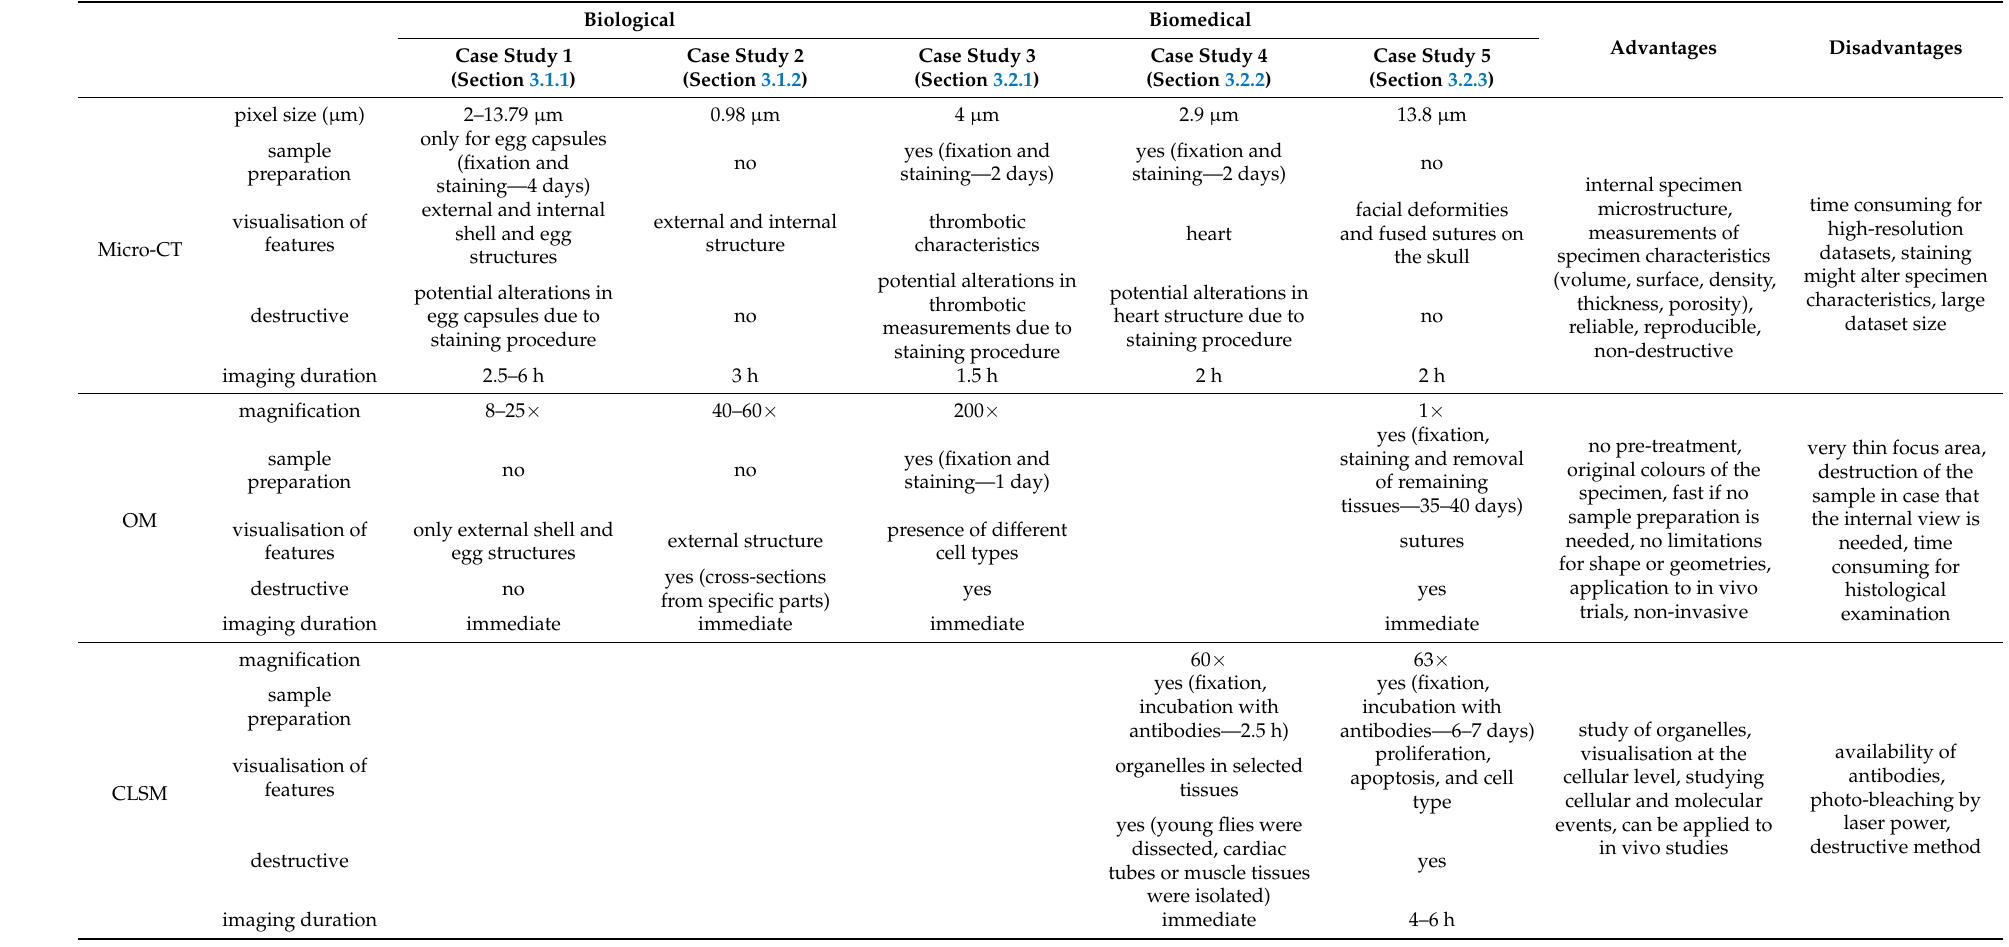
Table 1. Brief description of the case studies presenting the imaging properties and the advantages and disadvantages of each